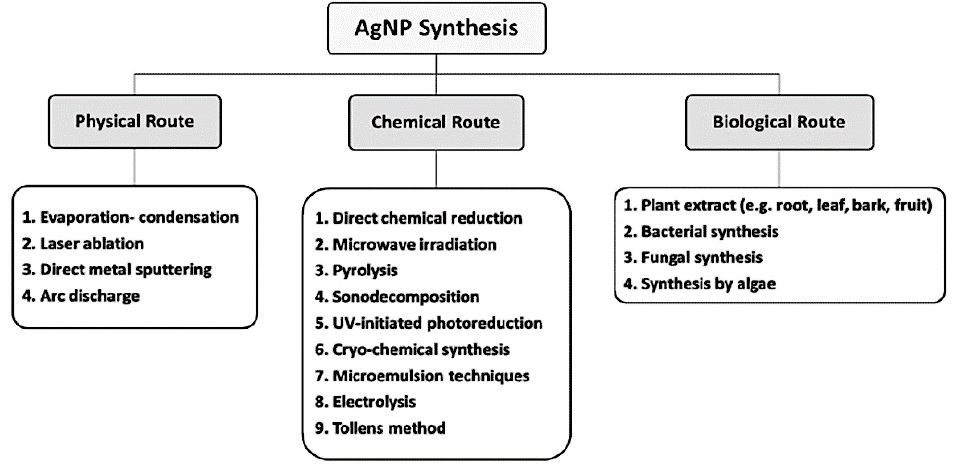
ff erent routes of AgNPs Figure 1. Different routes of AgNPs synthesis. Figure 1. Di